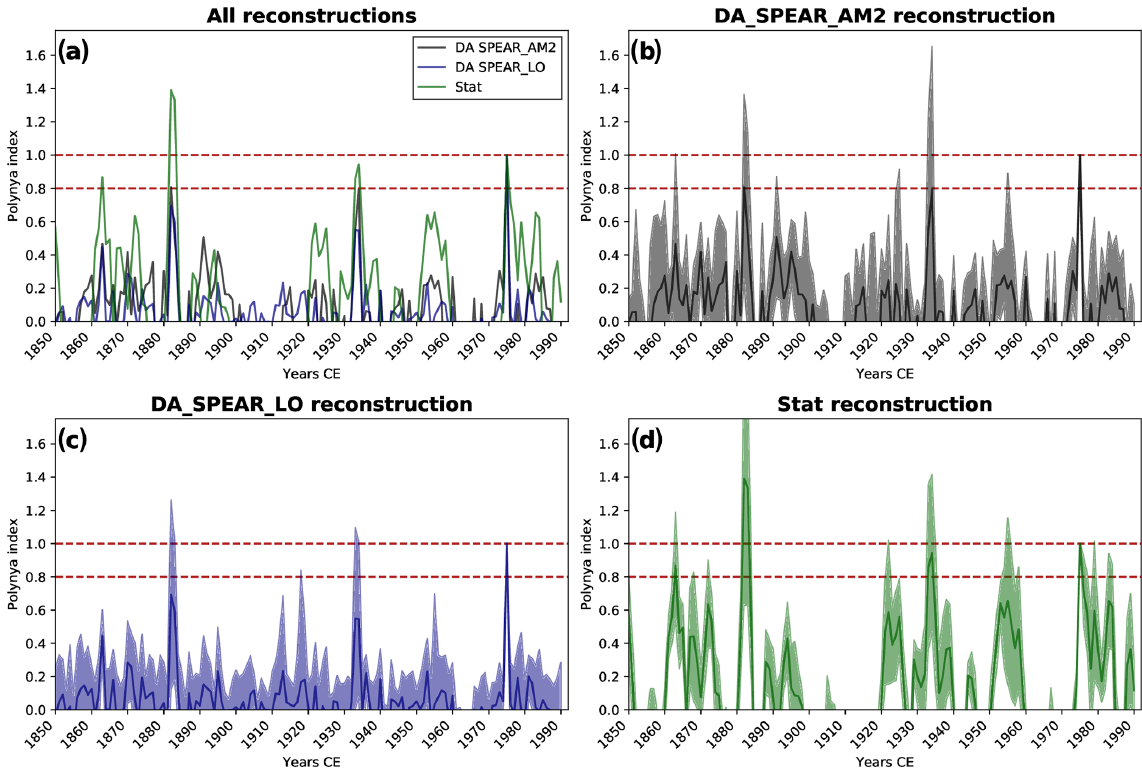
Figure 6. (a) Index of polynya activity for the years from 1850 to 1990 based on six surface mass balance records using data assimila- tion with SPEAR_AM2 (DA SPEAR_AM2 black), data assimilation with SPEAR_LO (DA SPEAR_LO, blue) and a simple average of the standardized time series (Stat, green). Index of polynya activity with the uncertainties estimated from the standard deviation of the seven reconstructions using six and all of the combinations of five different records for the reconstruction using (b) data assimilation with SPEAR_AM2, (c) data assimilation with SPEAR_LO and (d) a simple average of the standardized time